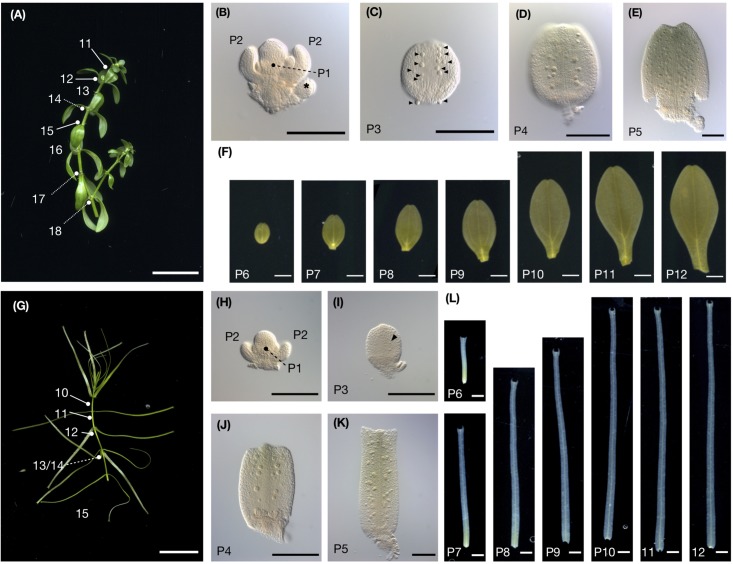
C. palustris leaf development. (A) Shoot grown in air. Node numbers counted from the shoot apex are indicated. (B) The shoot apex from panel A dissected showing nodes 1 and 2. P1 leaves are borne perpendicular to P2. Asterisks indicate floral buds. (C–F) show leave dissected from the shoot shown in panel A. (C) microscopic image of P3, (D) P4, (E) P5, and (F) scanned images of P6–P12. (G) A shoot grown underwater. (H) The shoot apex shown in panel G dissected showing nodes 1 and 2. (I–L) Leaves dissected from the shoot shown in panel G. (I) Microscopic image of P3, (J) P4, and (K) P5, and (L) scanned images of P6–P12. Glandular hair cells in (C,I) are indicated by arrowheads. Scale bars: (A,G) 1 cm, (B–E, H–K) 100 μm (F,L) 1 mm.